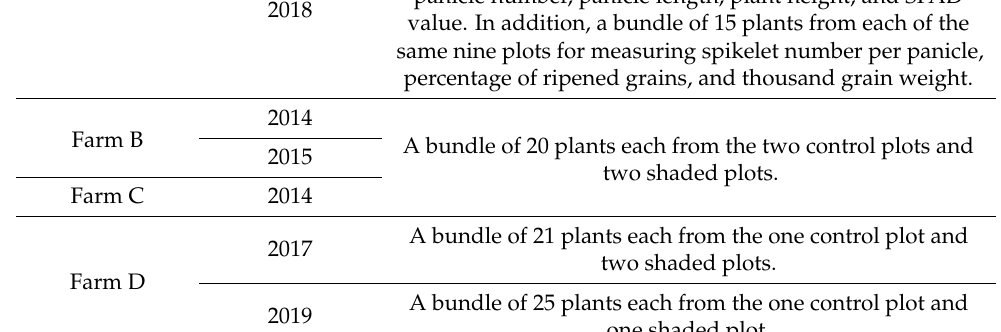
Table 3. Air temperature and solar radiation at experimental Farm A in 2017.